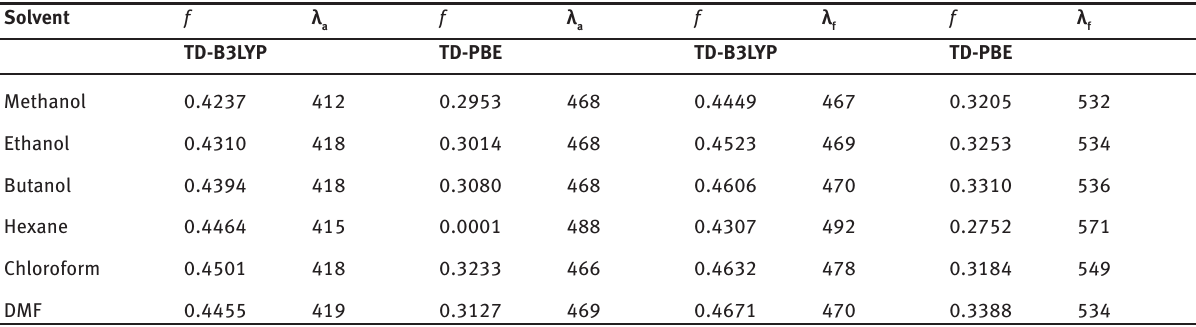
Table 2 : The computed values for absorption spectra (λ TD-PBE/6-31G** level of PBA in different